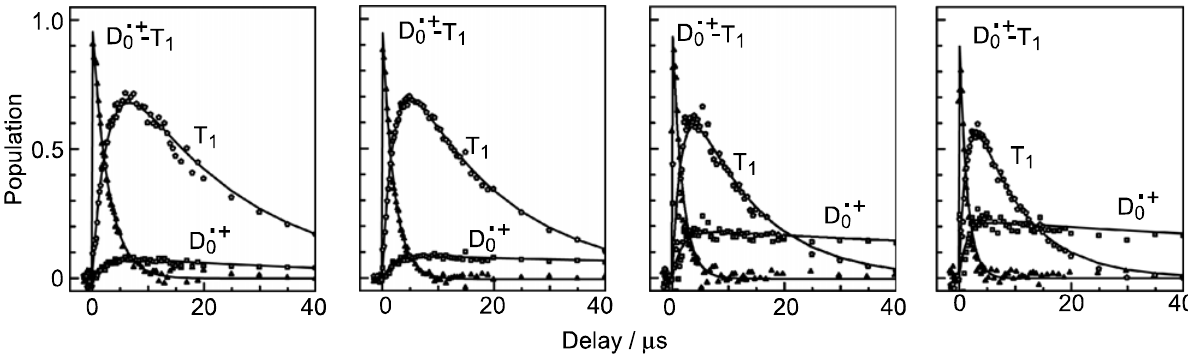
  T complex to the D 0 1  1 and k  1 ). The partition d0 t0